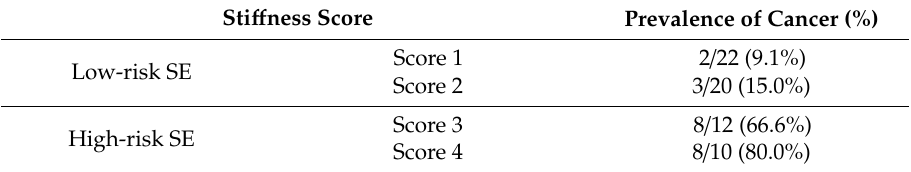
Table 2. The prevalence of malignant cases corresponding to qualitative SE classification. Sti ff ness